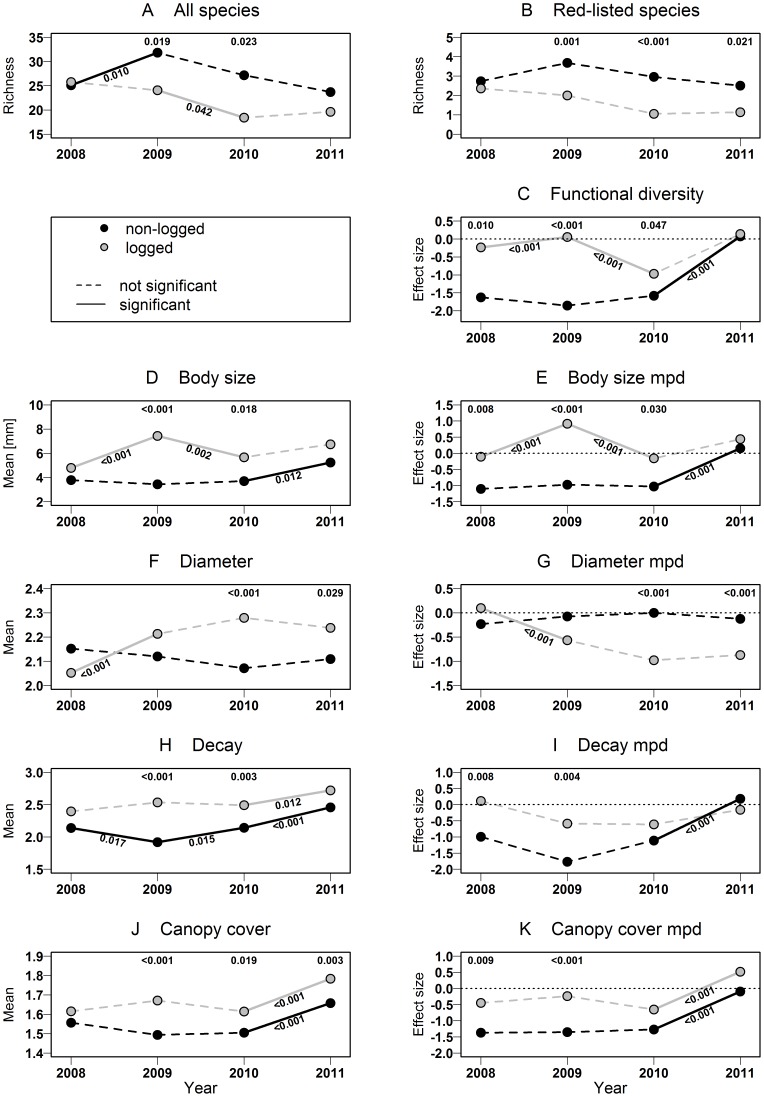
Effects of salvage logging on saproxylic beetles.Mean species richness of saproxylic beetles (A) and red-listed saproxylic beetles (B), abundance-weighted mean niche positions and standardized effect size (based on mean pairwise distance) of functional diversity (C) and body size (D, E), niche diameter (F, G), niche decay (H, I) and niche canopy cover (J, K) in logged and non-logged windthrow areas in a spruce mountain forest based on a GLMM with treatment and year as fixed factors, and space and plot as random factors. For multiple comparisons between treatments, the adjusted p-values are drawn above the respective points; for comparisons between different years within the same treatment, p-values are drawn below respective lines. Full details on p-values and model estimators can be found in Tables S2 and S3.